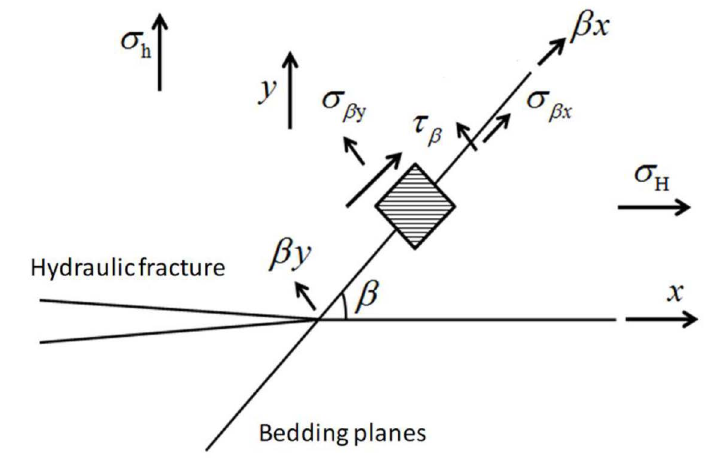
Figure 2. Schematic of HF approaching